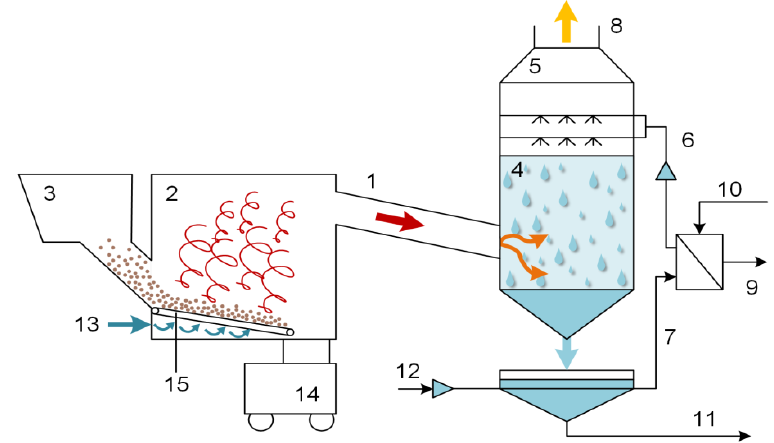
Fig. 1. Principal scheme of direct contact heating